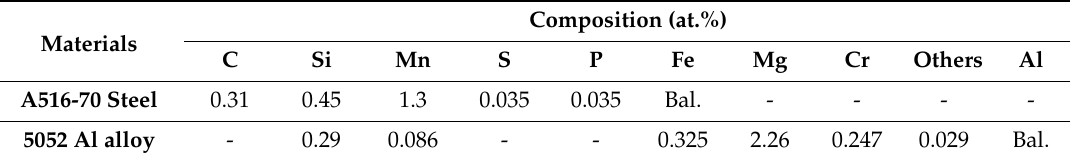
Table 1. Elemental compositions of ASTM A516-70 pressure vessel steel substrate material and cladding 5052 Al